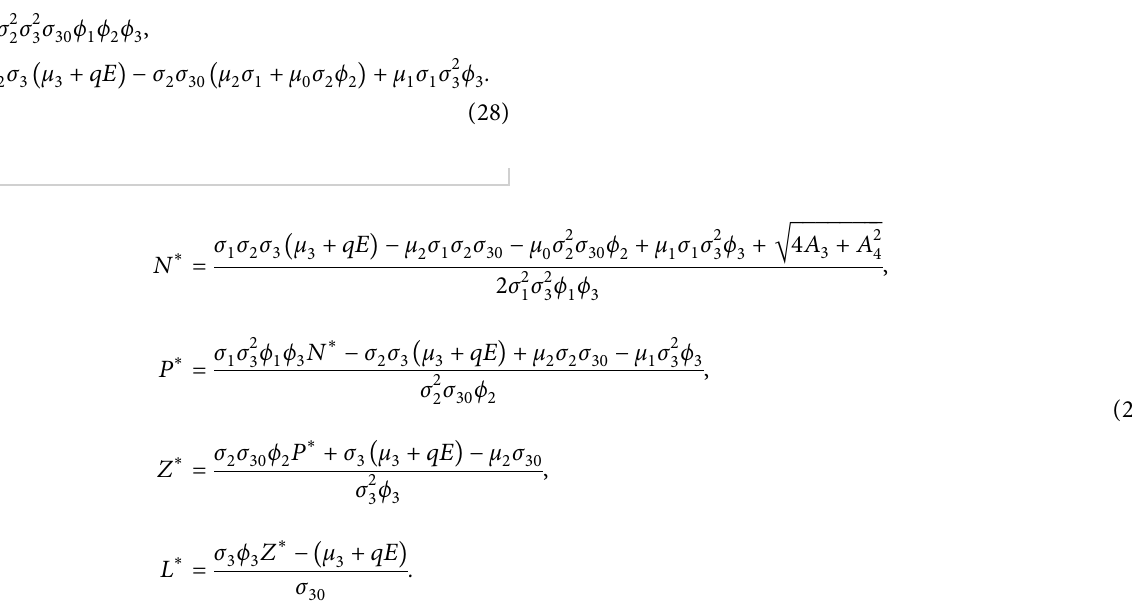
2.7. Stability Analysisfor the AutonomousModel. If b � c �